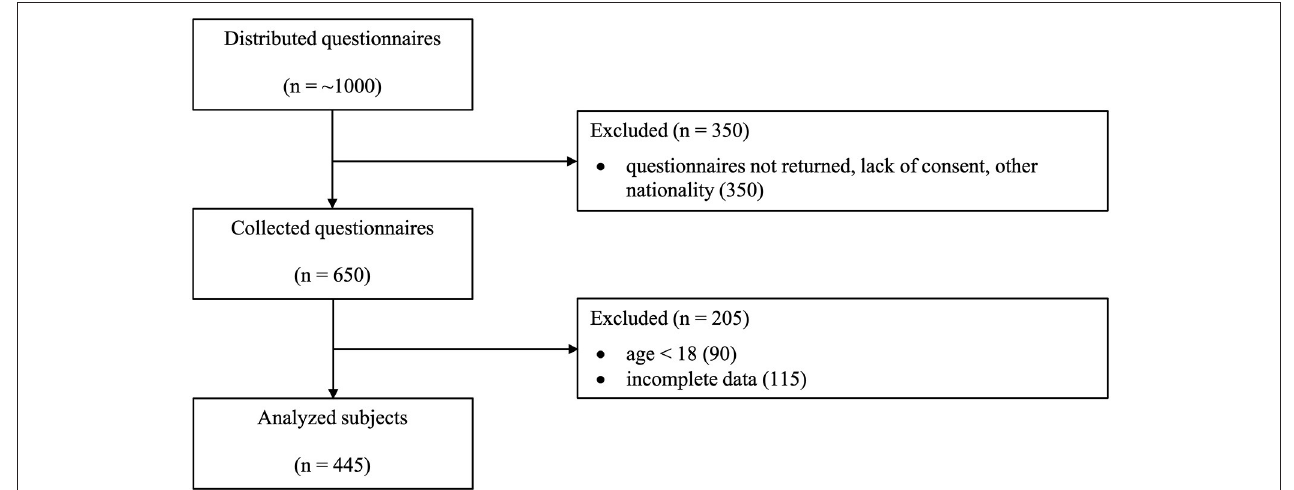
FIGURE 1 | Selection process of respondents to obtain the research